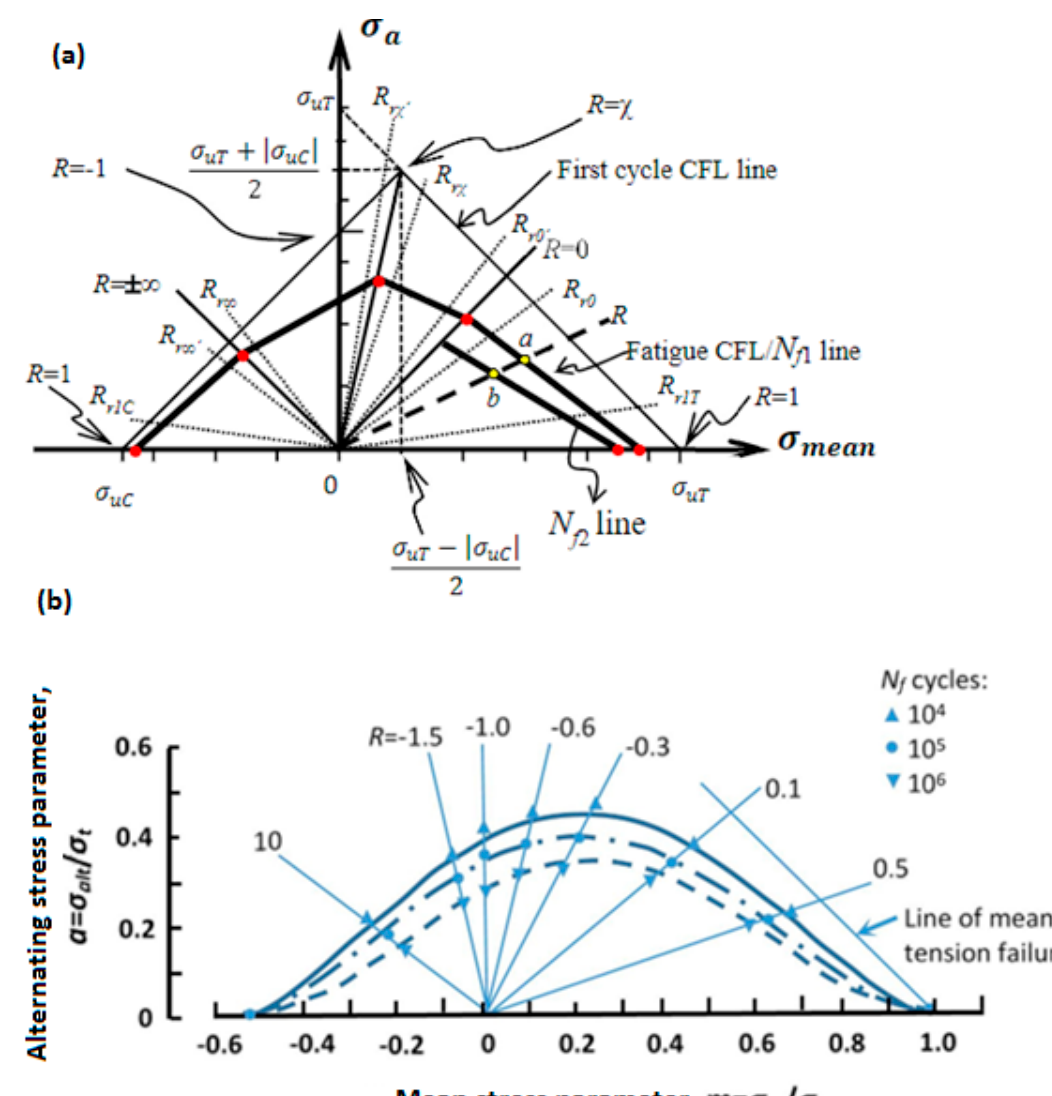
Figure 15. ( a ) A schematical illustration of cyclic loading ratios (adapted with permission from Ref. [75]. Copyright © 2019 Elsevier Ltd.) and ( b ) an exemplary illustration of fatigue life based on the Goodman diagram for carbon/Kevlar-49/epoxy laminate (adapted with permission from Ref. [64]. Copyright © 2020 Elsevier